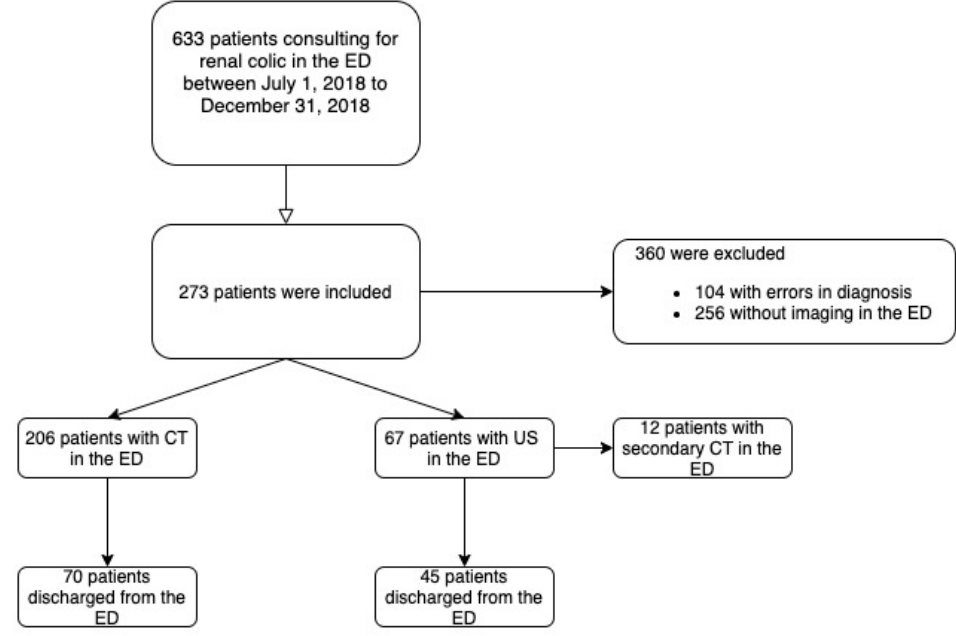
Figure 1. Flowchart of the study conducted in the ED of a University Hospital in France. ED: emergency department. CT: computed tomography.